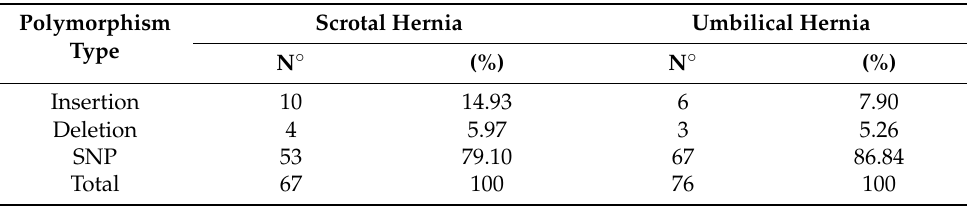
Table 5. Classification of polymorphisms found in samples from the inguinal and umbilical ring tissues from normal, and scrotal and umbilical hernia-affected pigs, respectively.